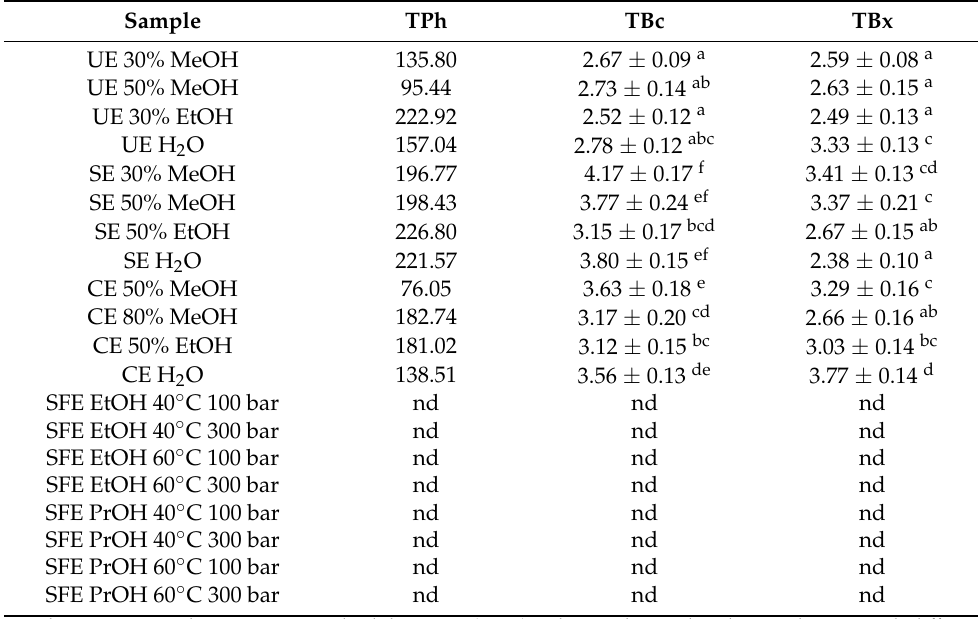
Table 1. Total phenolic and betalain compound contents of beetroot